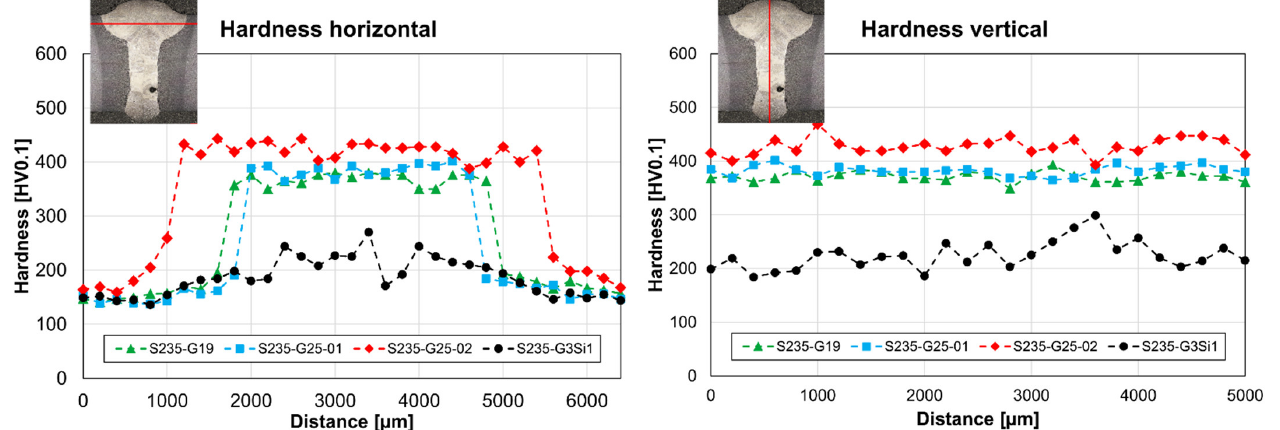
Figure 4. Hardness measurement horizontally ( left ) and vertically ( right ) to the weld seam showing increased hardness values for the LTT welds.